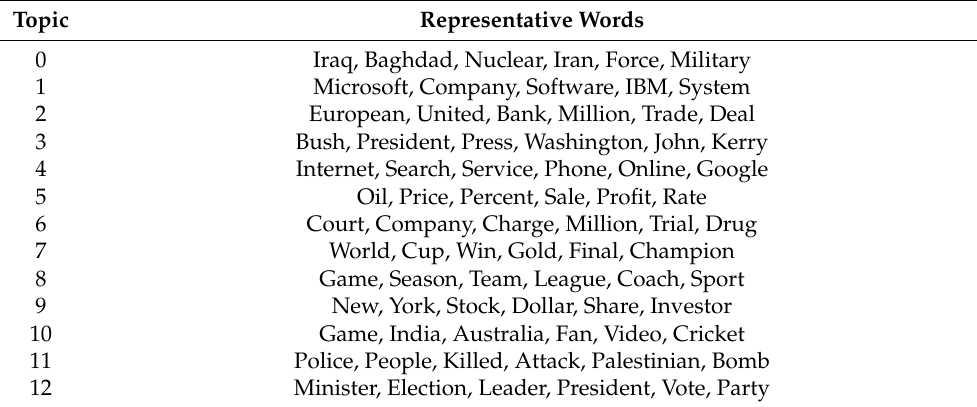
Table 1. Learned LDA topics and most representative words for the AG News Dataset.